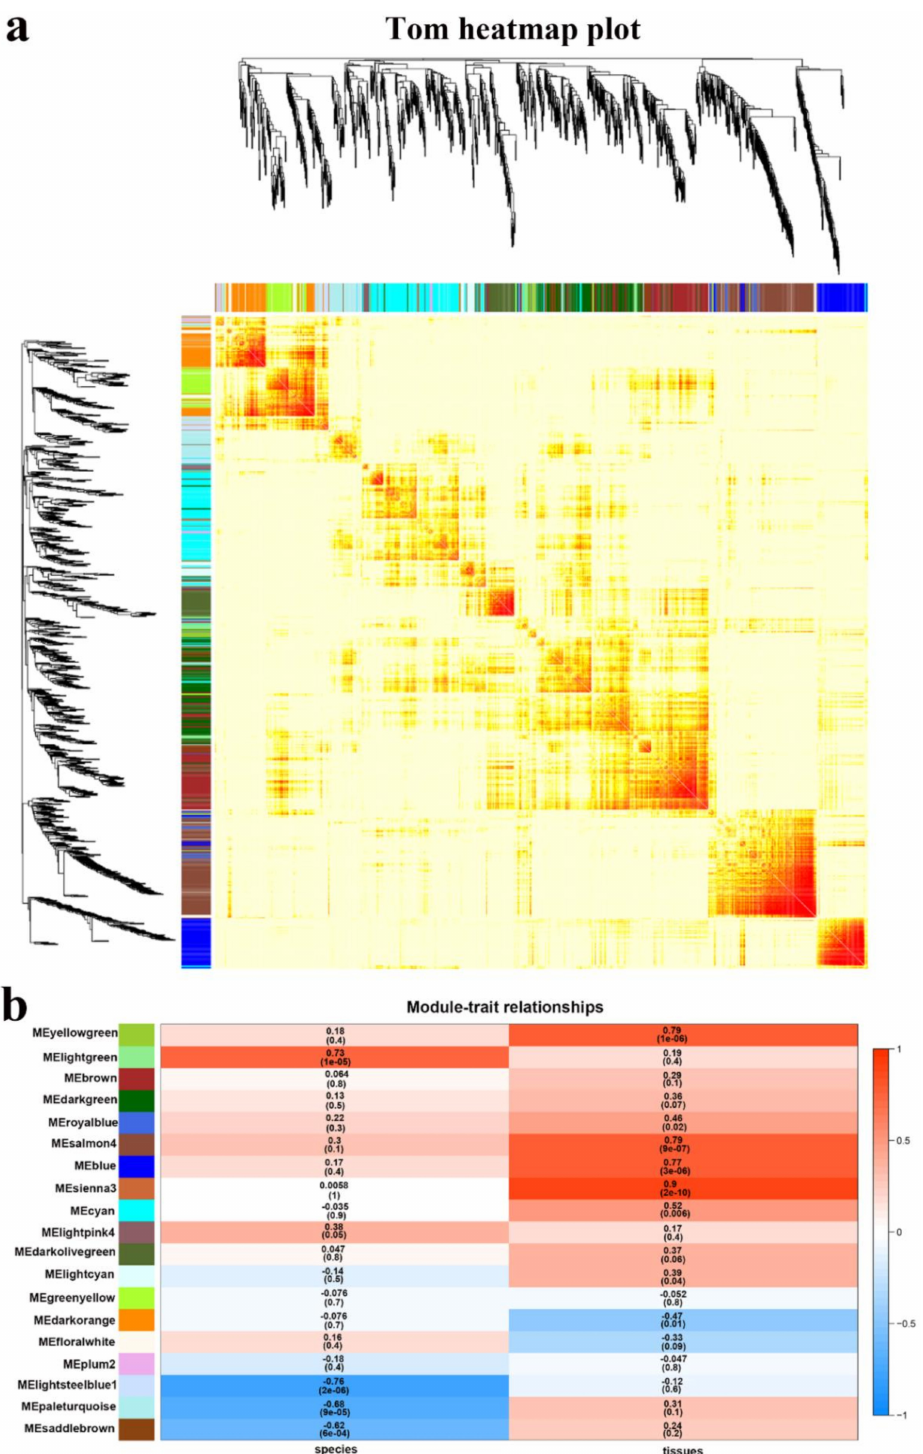
Figure 8. Co-expression network analysis across di ff erent tissues and di ff erent species. ( a ) Visualizing the gene network using a heatmap plot. The heatmap depicts the topological overlap matrix (TOM) among all genes in the analysis. ( b ) Module-trait associations. Each row corresponds to a module characteristic gene (eigengene), and each column corresponds to a trait. Each cell contains a corresponding correlation and p -value. According to the color legend, the table is color-coded by